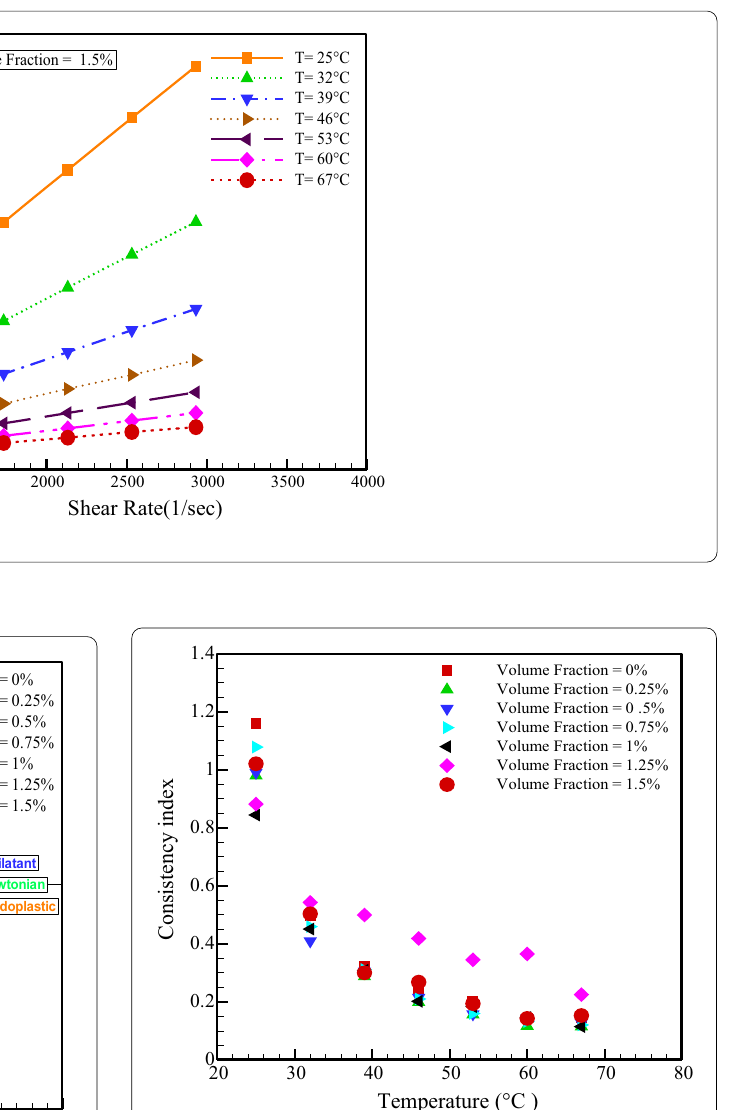
Fig. 6 Changes of strength index with temperature for